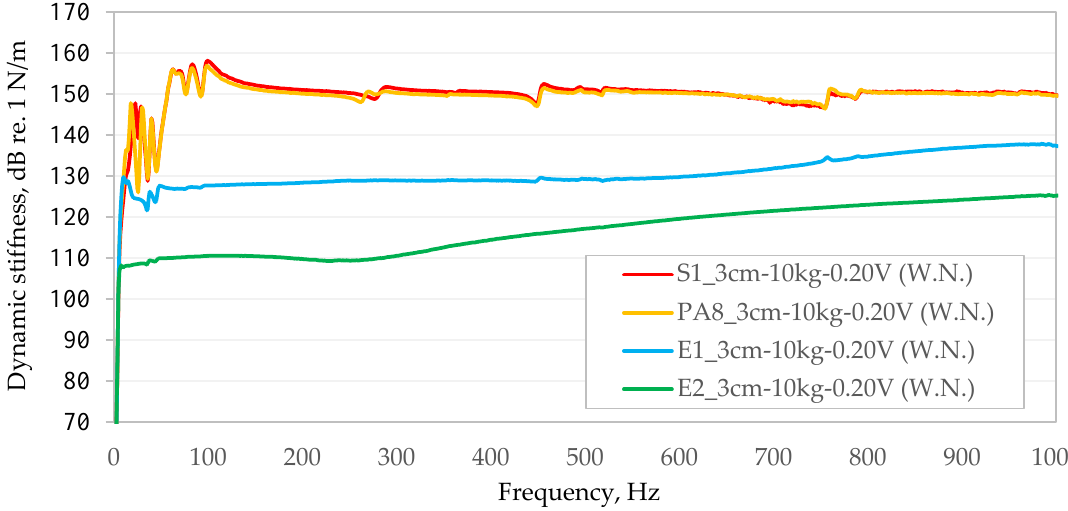
ff ness of samples tested in the first stage. Materials 2020 , 13 , x FOR PEER REVIEW